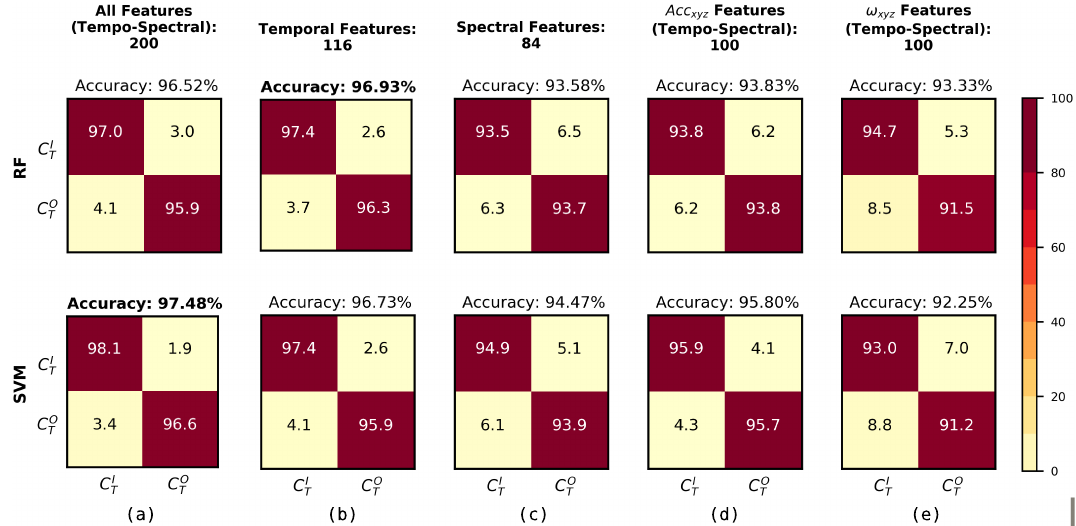
Figure 4. Confusion matrices of indoor–outdoor terrain classification computed with lower back sensor. Each column represents a feature set: ( a ) all features (194 features), ( b ) time (110 features), ( c ) frequency (84 features), ( d ) accelerations (97 features) and ( e ) angular velocities (97 features). Each row represents a classifier (from ( top ) to ( bottom )): RF and SVM. Classes: C I = outdoor (grass, Asphalt, C O T